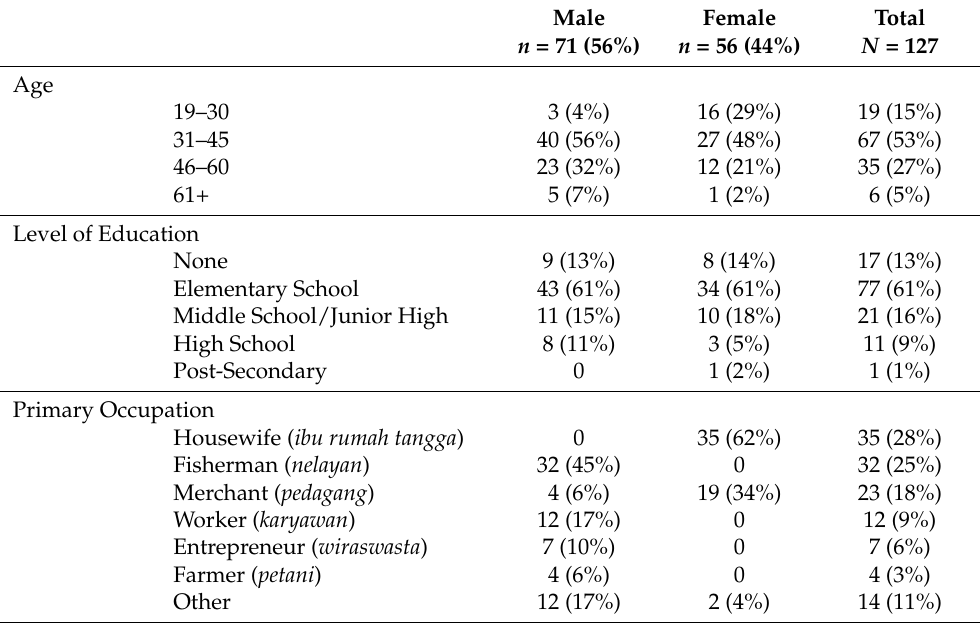
Table 1. Demographic profiles of survey participants ( N = 127) interviewed about snake experiences, attitudes, and behaviors in Banten,